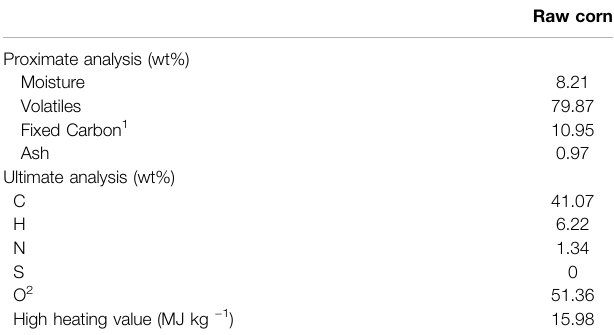
TABLE 2 | Proximate and ultimate analysis of raw corn.